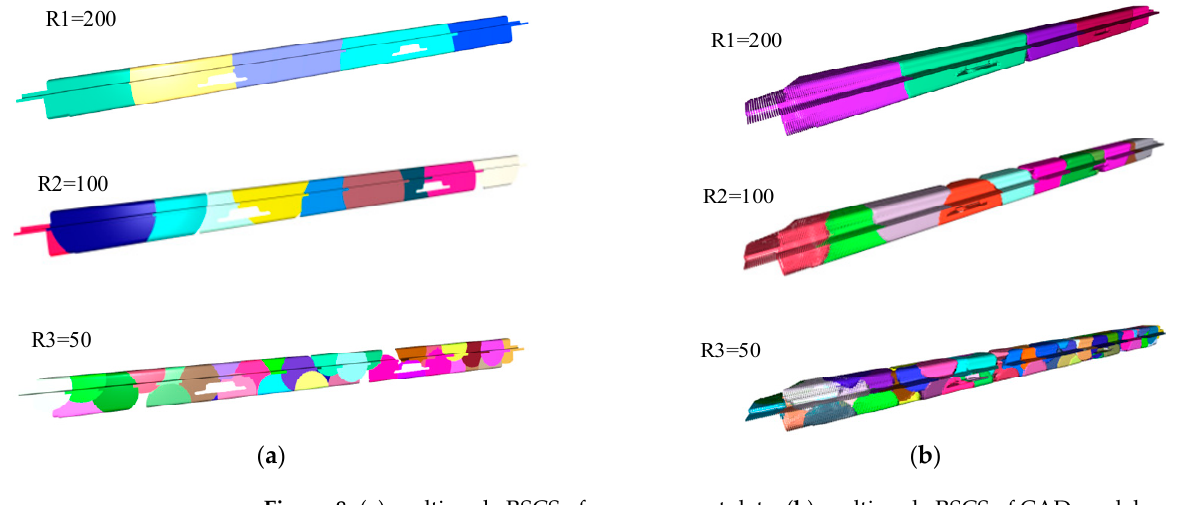
Figure 8. ( a ) multi-scale RSCS of measurement data; ( b ) multi-scale RSCS of CAD